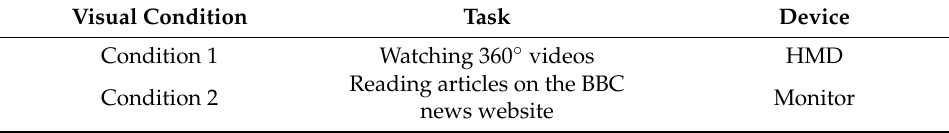
Figure 1. Examples of the 360° videos through the HMD device included in this study. Table 1. The differences between the contents of both visual